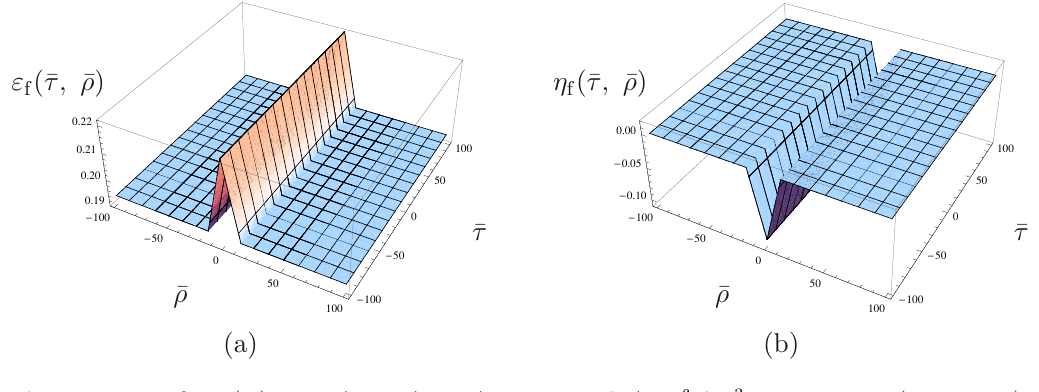
d p − 3 x √ g p − 3 = 1 , ( p = 4 , 6 , 8), and R